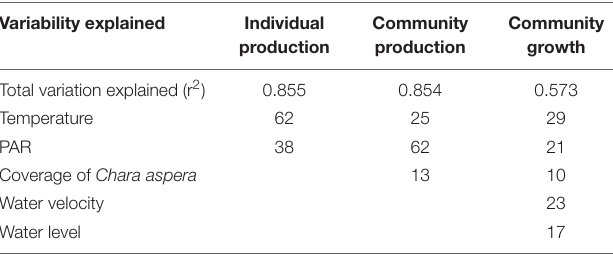
The contributions of environmental variables are relative contributions to the models’ total variable explained